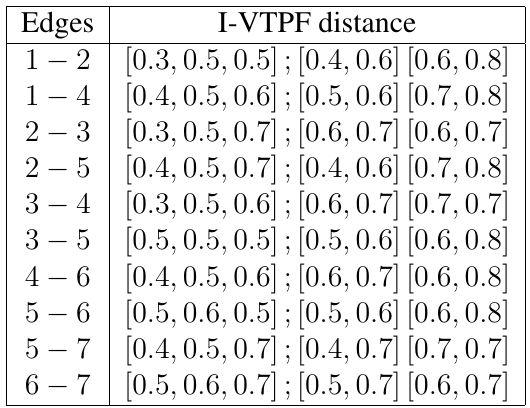
Table 1: I-VTPFNs edge